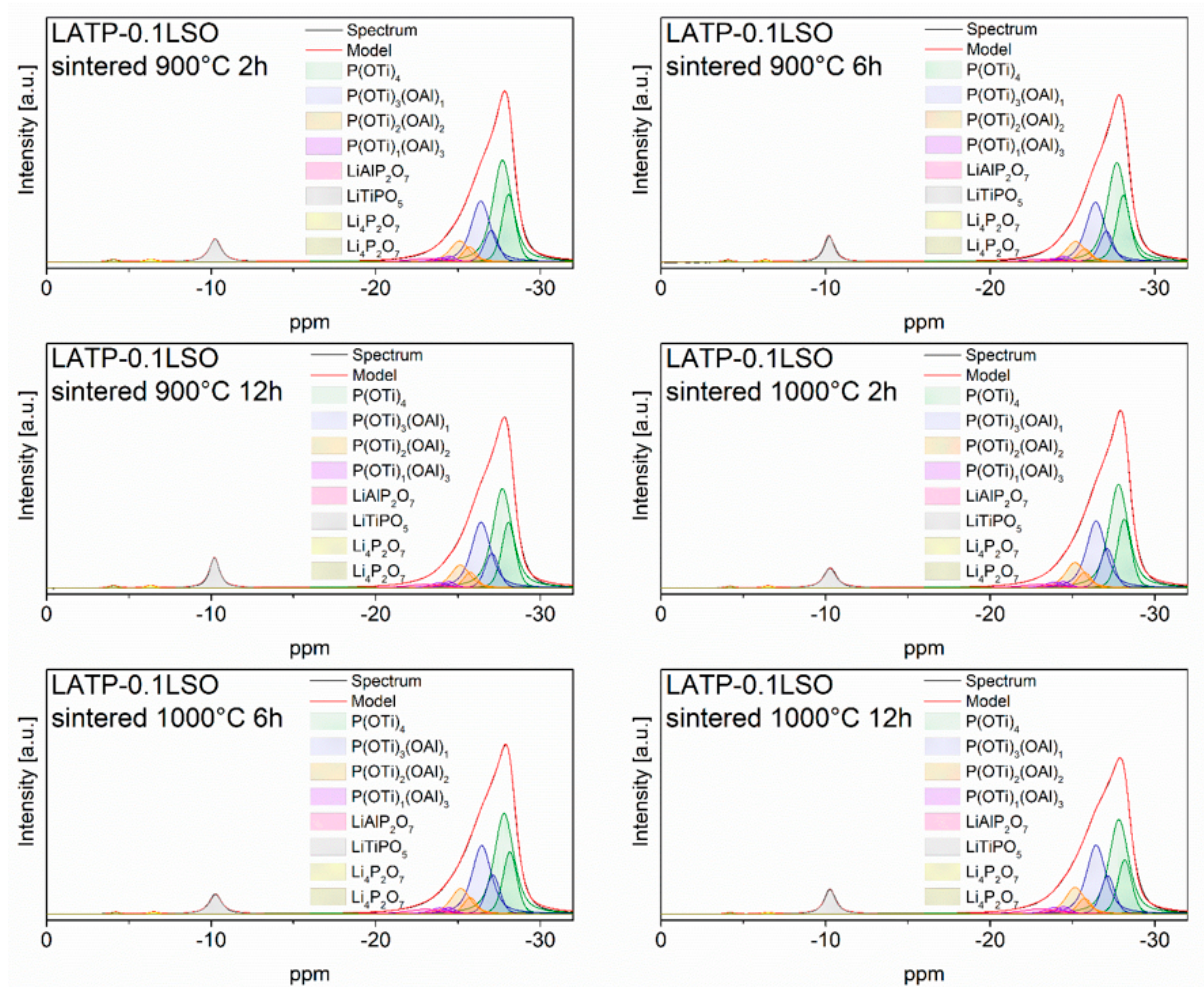
Figure 5. 31 P MAS NMR spectra of LATP–0.1LSO sintered at 900 and 1000 ◦ C for 2, 6, or 12 h. The experimental and simulated spectra are displayed as black and red lines, respectively. The simulated spectra is the sum of distinct line-shapes displayed as colored